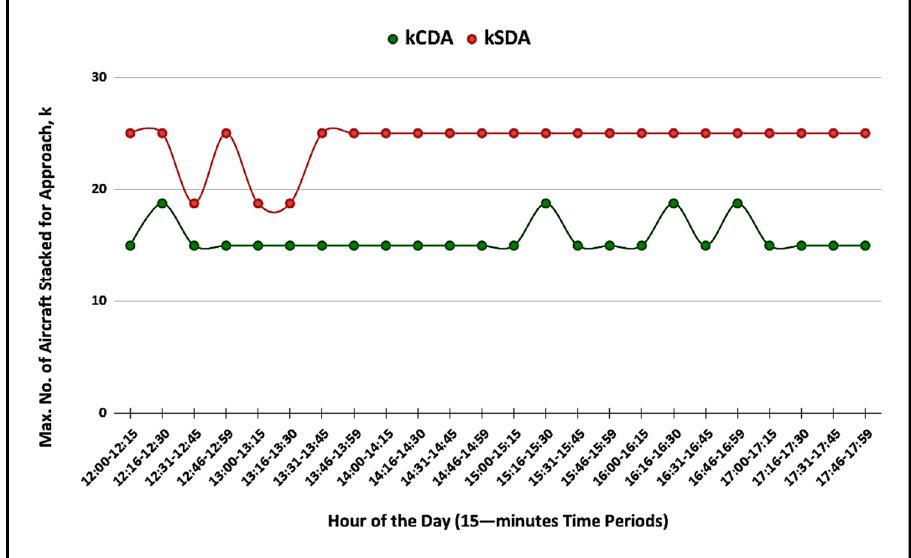
Figure 8. Capacity of the TMA’s stacking space k.